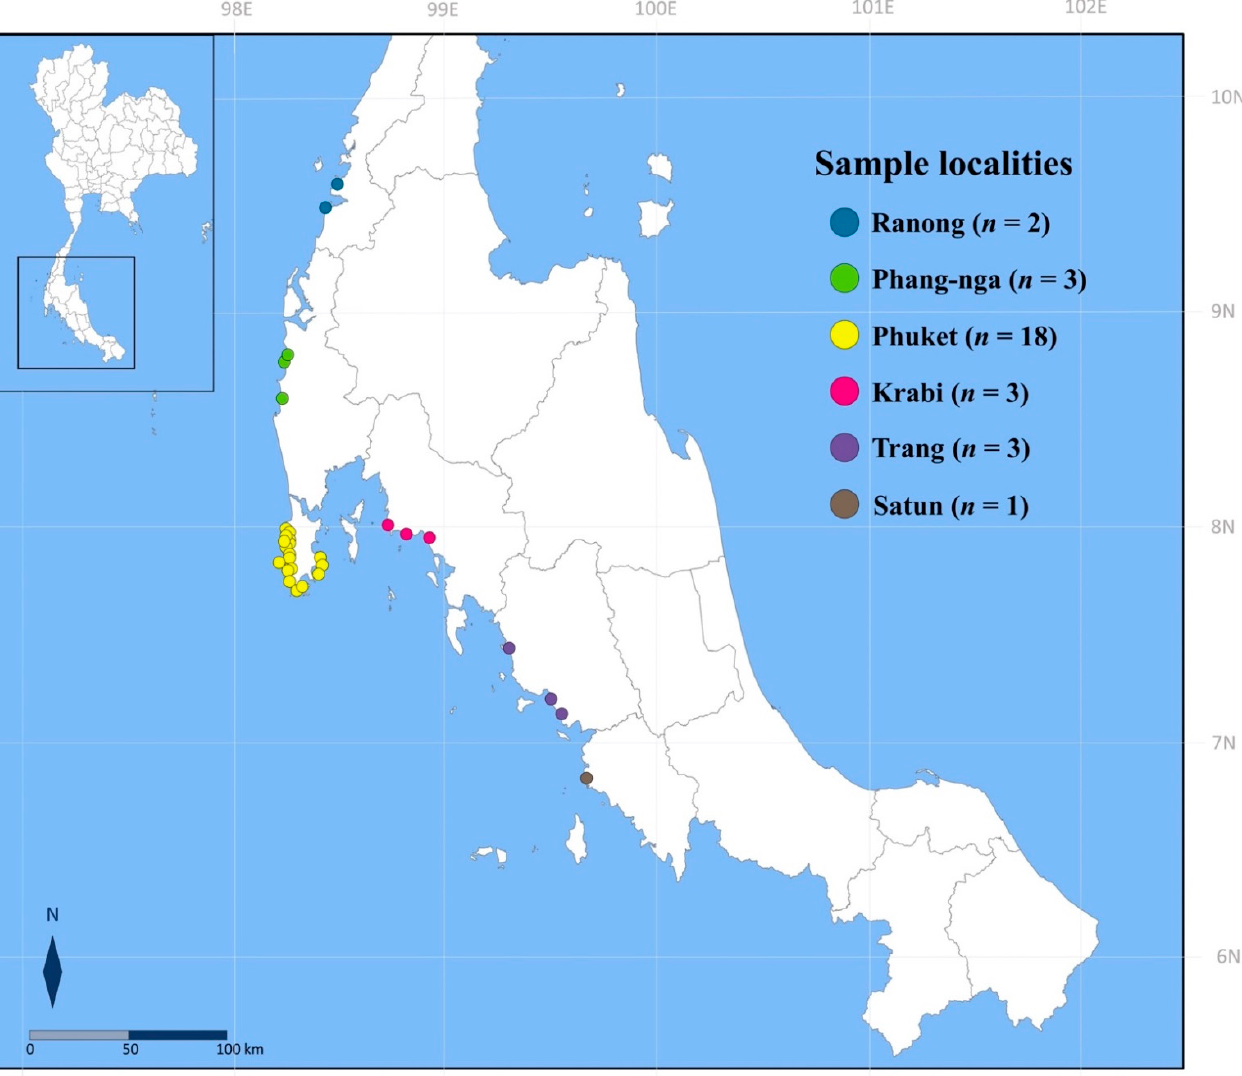
Figure 1. Map showing the location of stranded T. aduncus samples used in this study.